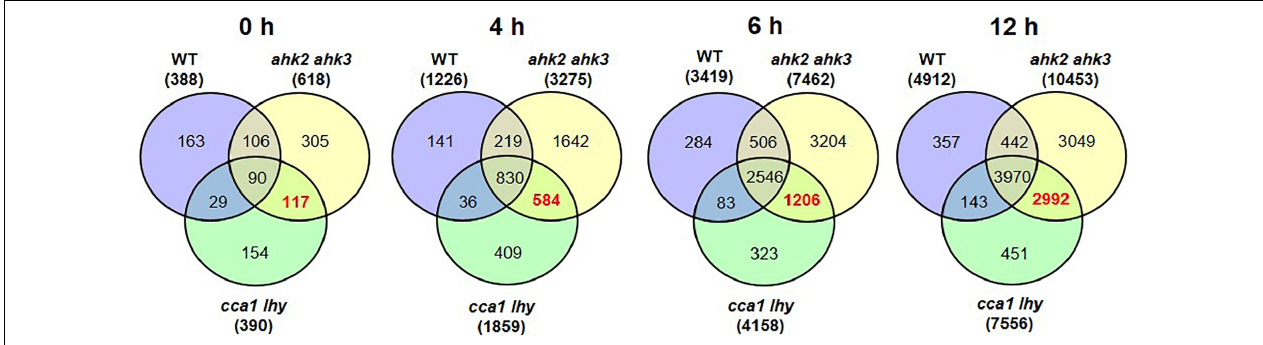
FIGURE 2 | Overlap of DEGs of the different genotypes in response to photoperiod stress. Venn diagrams showing the overlap of DEGs between WT, ahk2 ahk3 and cca1 lhy at different time points after photoperiod stress treatment. 5-week-old short-day (SD)-grown plants were exposed to an extended light period of 32 h followed by a normal SD night (see Figure 1A ). Numbers in brackets indicate the total number of DEGs (| fold-change| = 2; Bonferroni-corrected p -value ≤ 0.05) in prolonged light period (PLP)-treated plants compared to control plants at the respective time points. The bold red number in the Venn diagram indicates the number of DEGs occurring specifically in the stress-sensitive genotypes ahk2 ahk3 and cca1